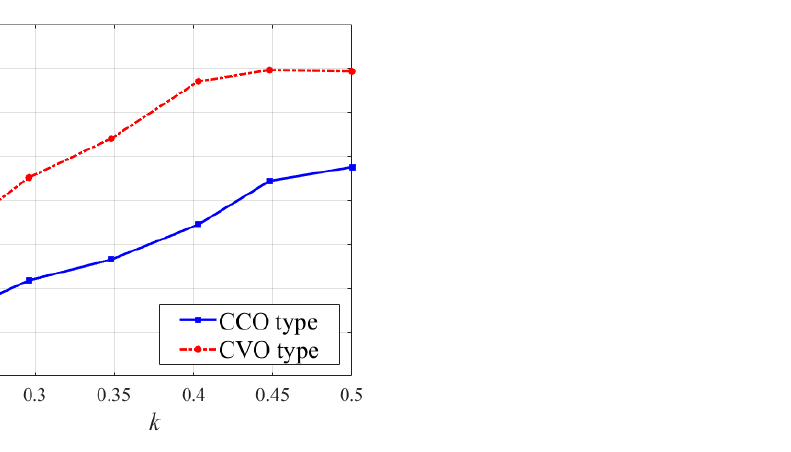
Figure 14. Measurement efficiencies of two new designed parameters when the k changes due to misalignment.